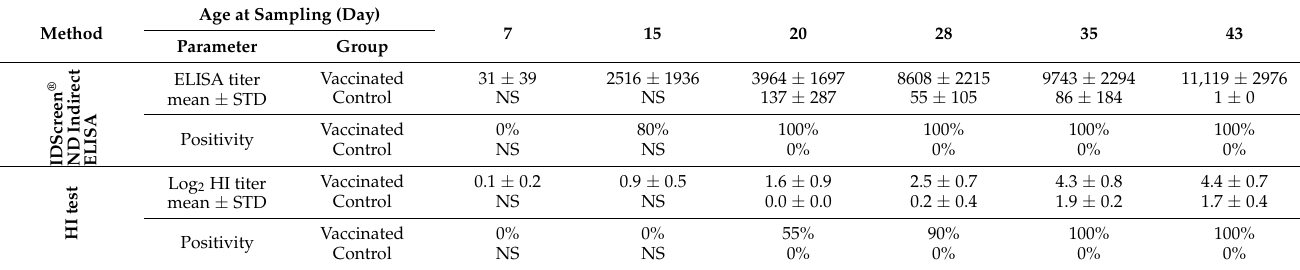
Table 3. Humoral immune response to vaccination- ELISA and hemagglutination-inhibition test results.